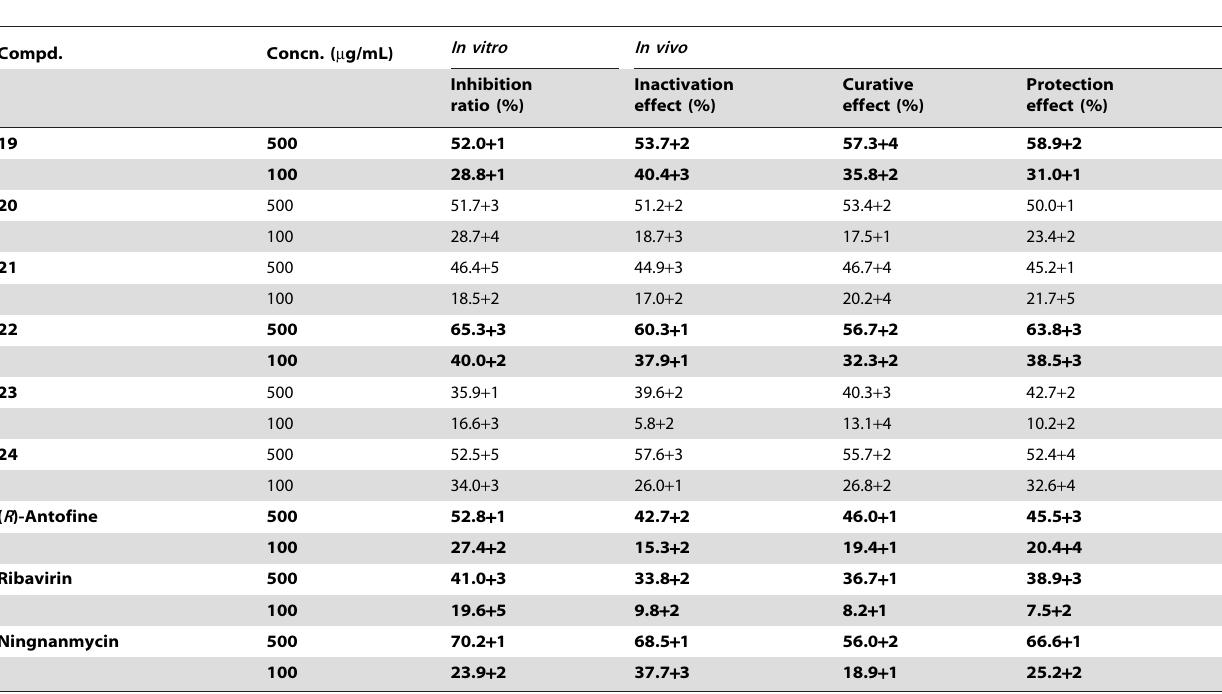
Table 3. In vitro and in vivo anti-TMV activity of 15-hydroxyphenanthroquinolizidine alkaloids 19–24.